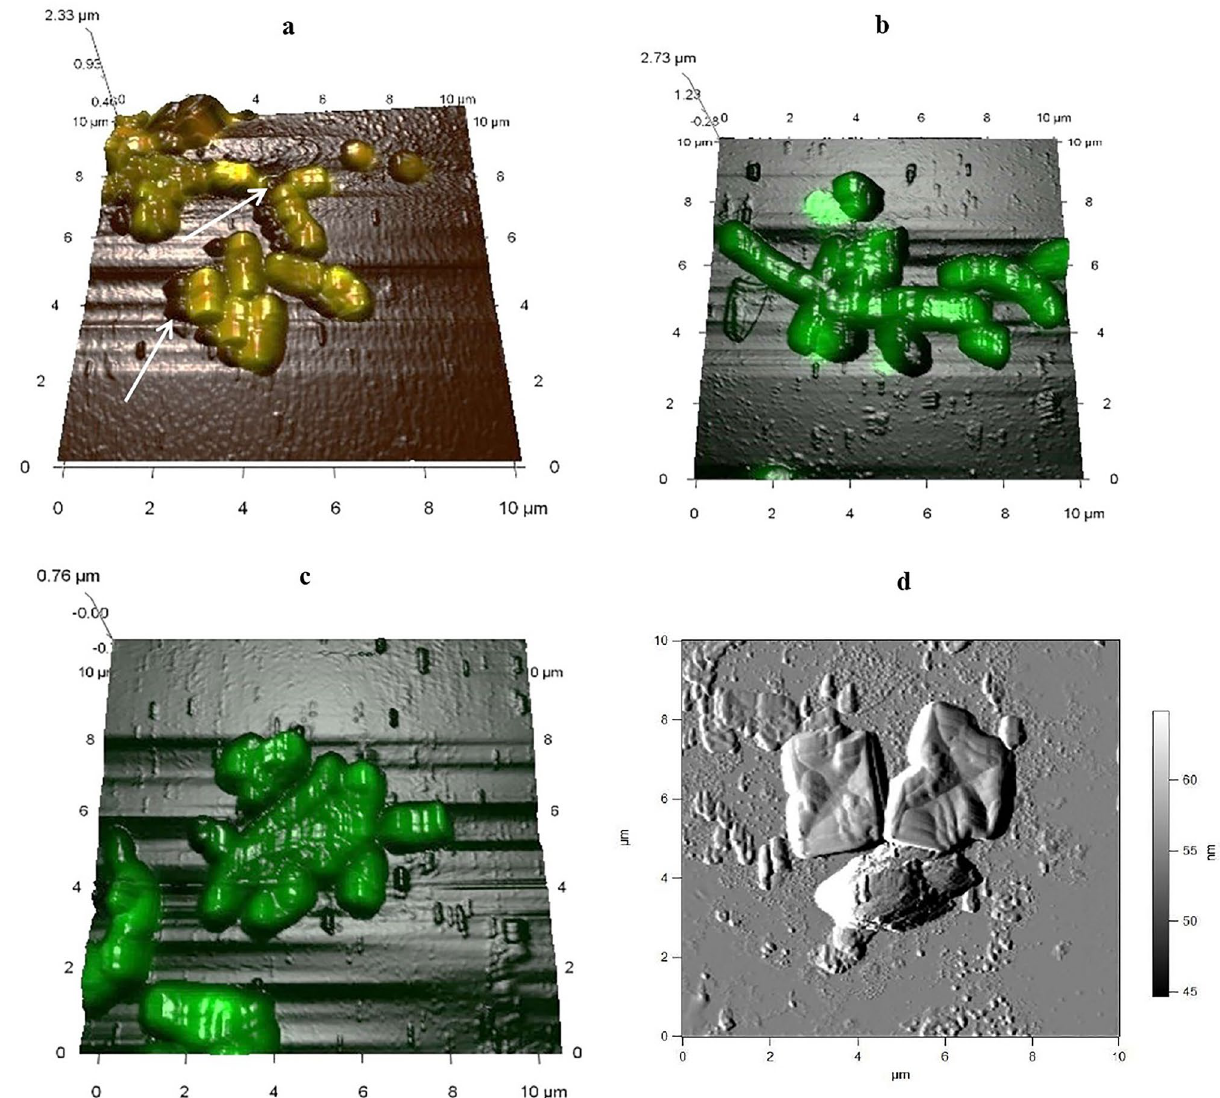
Figure 4. Combined AFM/CLSM images of Rhodococcus cells after 9 days of n- hexacosane biodegradation. Experimental variants: ( a ) R. opacus IEGM 262 grown in the presence of 0.2% (w/w) n- hexacosane; ( b ) R. opacus IEGM 262 grown in the presence of 0.2% (w/w) D-glucose (biotic control); ( c ) R. erythropolis IEGM 212 grown in the presence of 0.2% (w/w) n- hexacosane; ( d ) cell-free medium with 0.2% (w/w) n- hexacosane (abiotic control). Cells are stained with LIVE/DEAD® Bac Light™ Bacterial Viability Kit: green—living cells, mixed green/ red—living but partially damaged or unstained cells, black—abiotic objects (hydrocarbon particles). Arrows show hydrocarbon